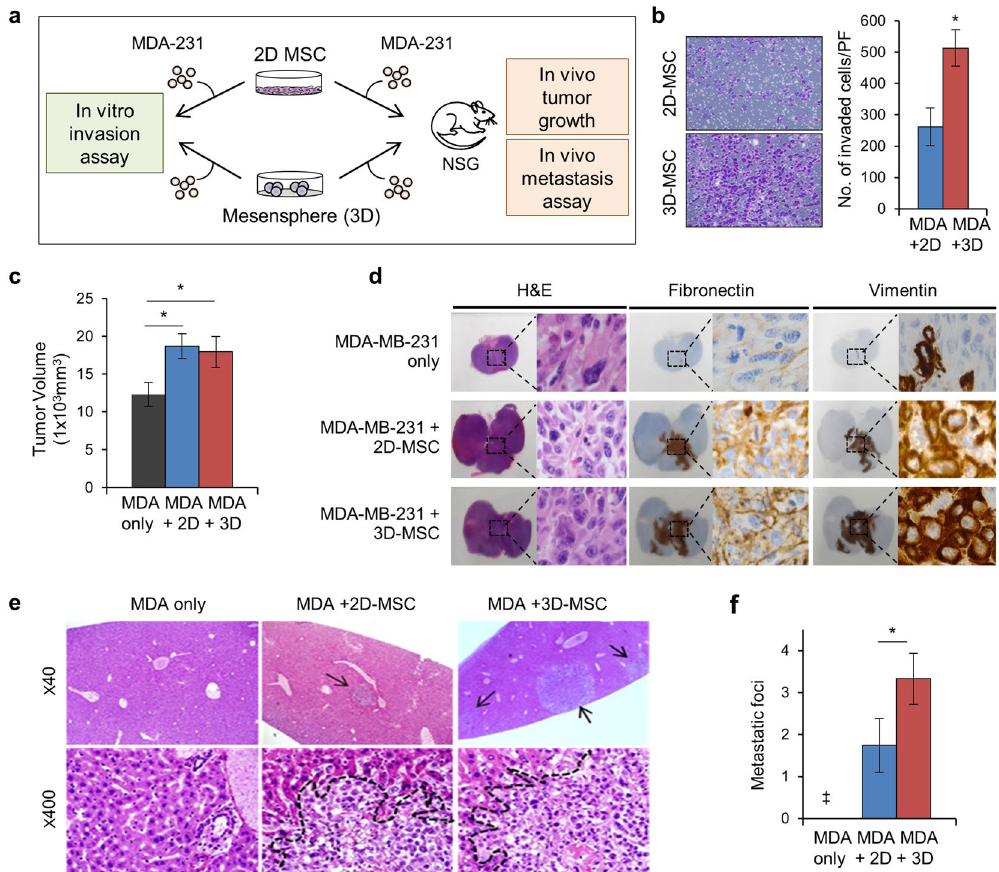
Figure 5. 3D spheroid MSCs represented an activated niche for cancer stem cells. ( a ) Schematic illustration of the experimental scheme. ( b ) In vitro invasion assay. MDA-MB-231 cells transduced with green fluorescence protein were plated in Matrigel-coated upper chambers of transwell plates with 2D or 3D MSCs. Shown are the representative images after staining with crystal violet and quantitative measurements of invading